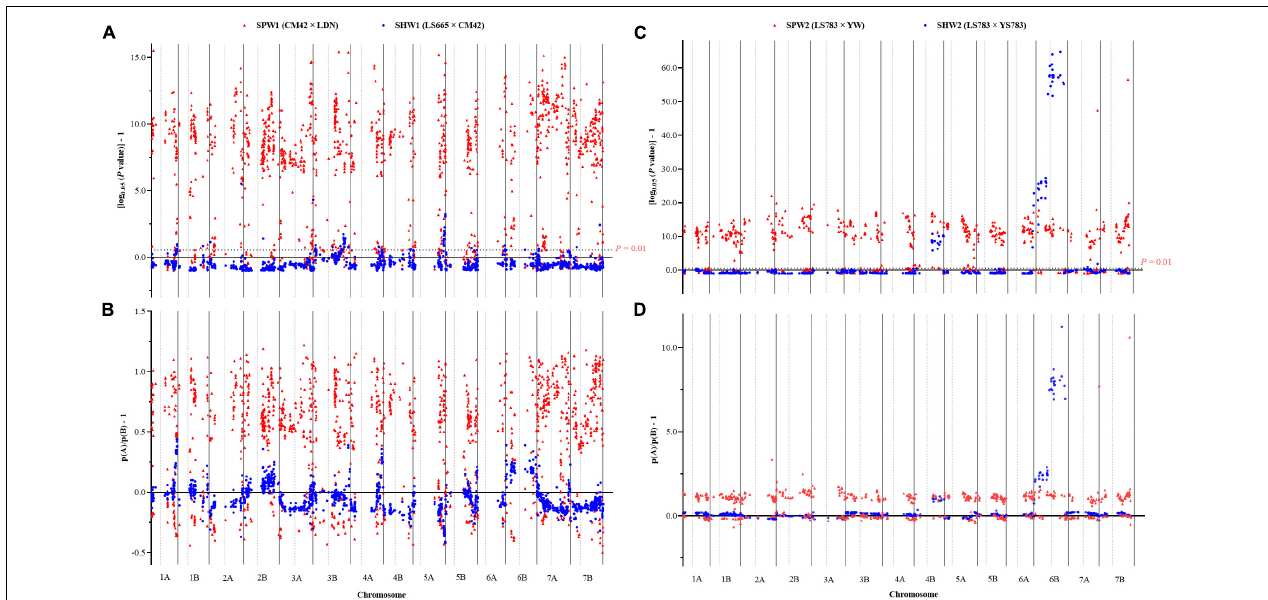
FIGURE 5 | The distorted segregation (A,C) and parental gene bias (B,D) of SNP markers of AB genomes in SPW and SHW populations. P -value was calculated by Chi-square test with a theoretical genotype frequency of 1:2:1 (AA: AB: BB). If the [log0.05 ( P -value) - 1] > 0 or 0.54 at a SNP site, significant distorted segregation was inferred at this locus at P = 0.05 or 0.01 level, respectively. p (A) means gene frequency of the female parent; p (B) means gene frequency of the male parent. If [ p (A)/ p (B)–1] > 0, the gene frequency of the female parent was higher than that of the male parent in the F 2 recombination populations, and the genotype was biased toward the female parent at this